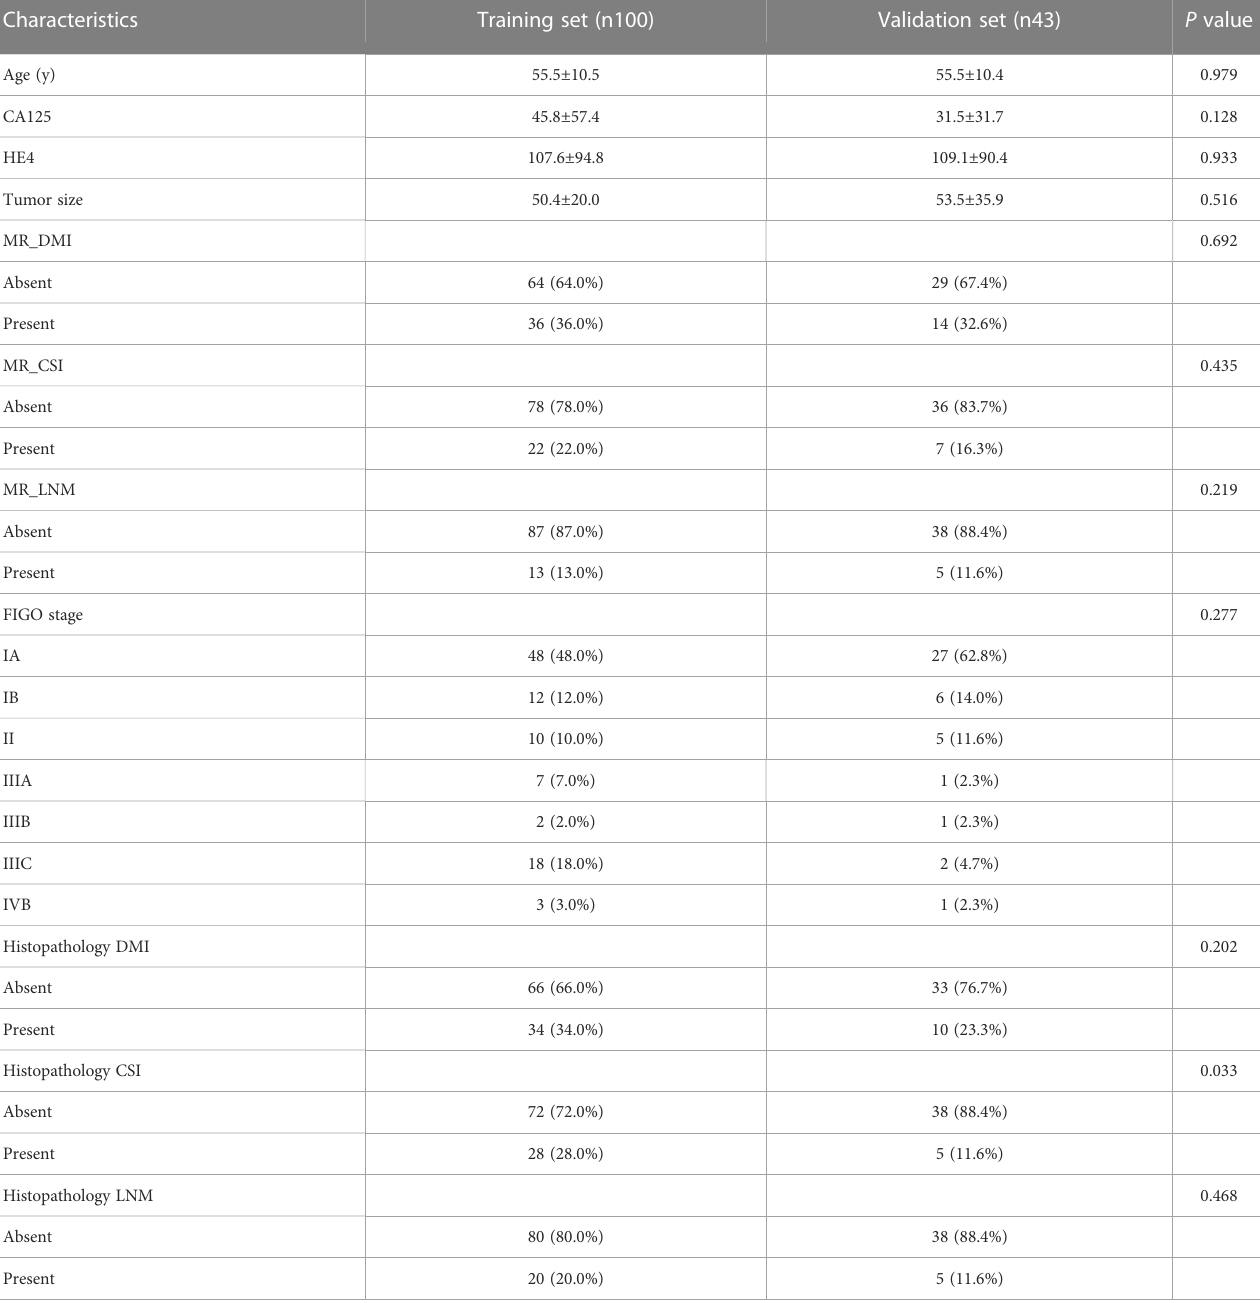
FIGO, Federation of International of Gynecologists and Obstetricians; HE4, human epididymis protein 4; MR_DMI, MRI-reported deep myometrium invasion; MR_CSI, MRI-reported cervical stromal invasion; MR_LNM, MR-reported lymph node